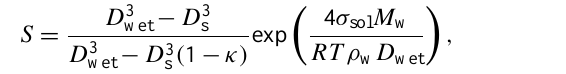
Table 2, respectively. Available data range from mid-2006